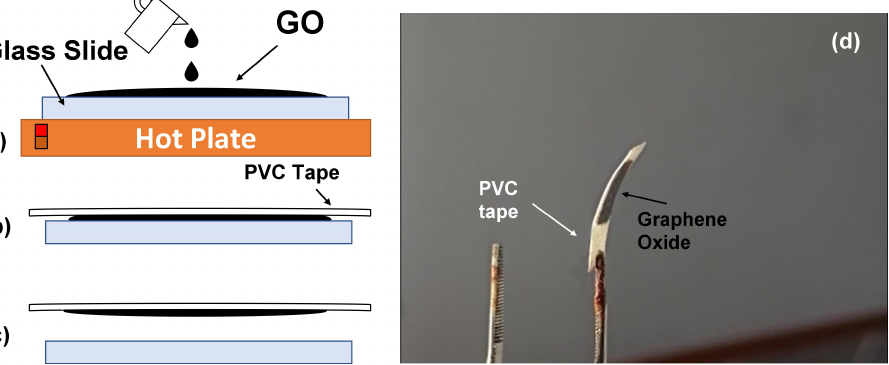
Figure 2. On the left side is a sketch of the preparation process. In ( a ), GO is deposited on a glass substrate placed on a hot plate at 60 °C. In ( b ), the PVC tape is placed in contact with the dried GO film, and in ( c ), the bilayered structure is detached from the substrate. On the right side ( d ) is the final